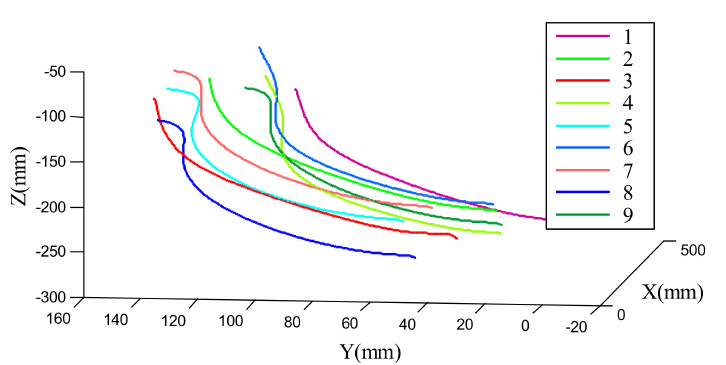
Figure 21. Marker movement